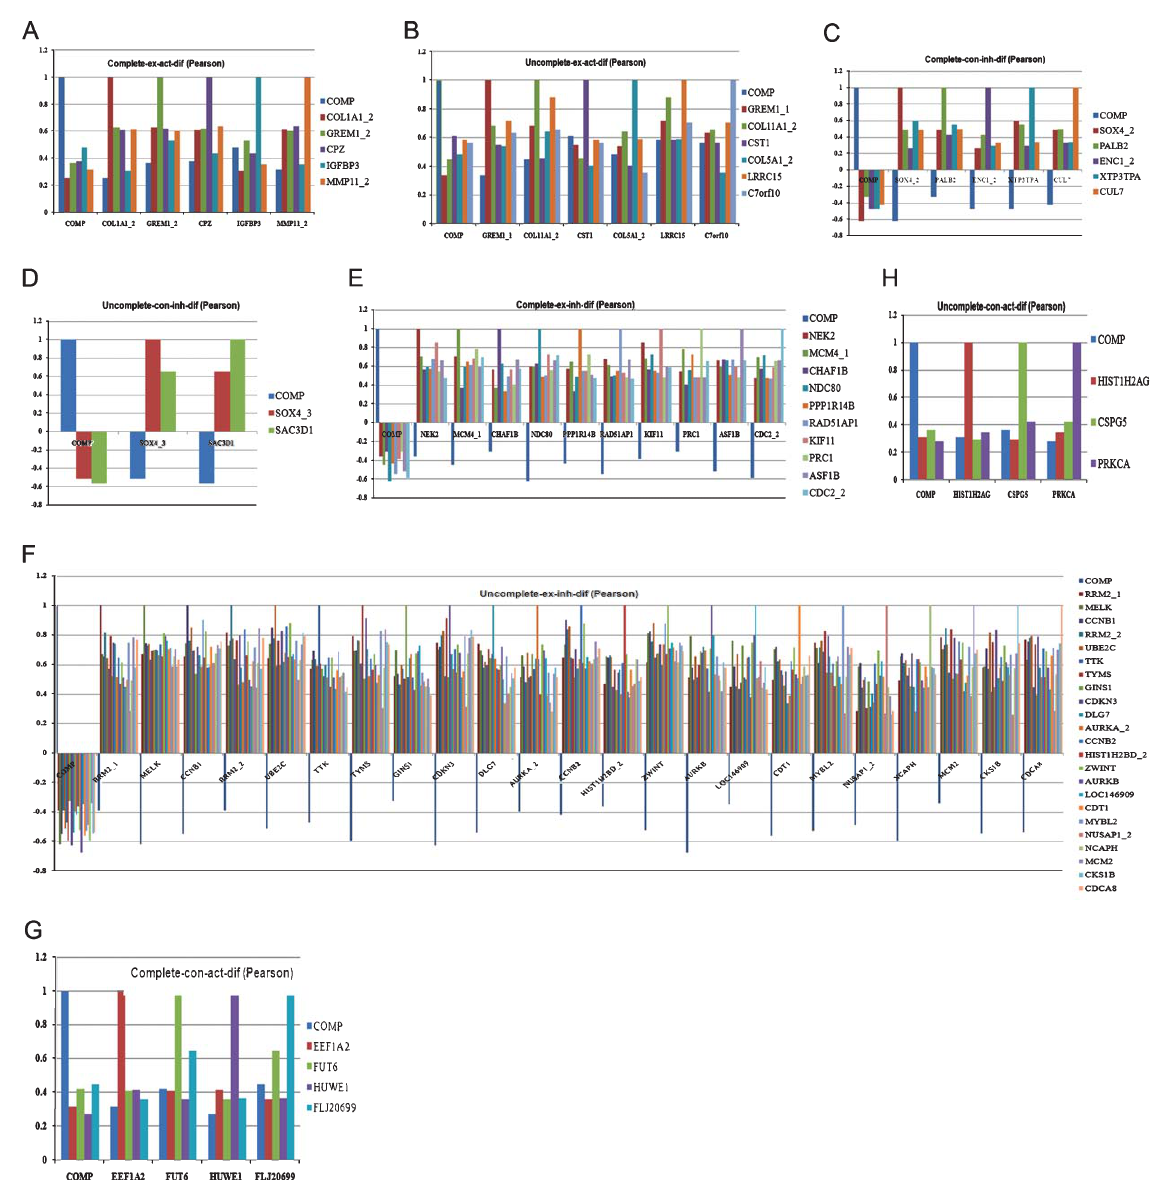
Fig. 1. Novel different COMP -activated and -inhibited networks by correlation coefficient (CC) and our programming. (A) Complete (all no positive correlation, Pearson CC<0.25) and (B) uncomplete (partly no positive correlation except COMP , Pearson CC<0.25) different COMP - activatednetworksgroupedverticalbarsquantificationchartinhigherlungadenocarcinomacomparedwithlowerhumannormaladjacenttissues by Pearson correlation coefficient (CC) and our programming, respectively. Vertical scale bars indicate CC value, n =25. (C) Complete and (D) uncomplete different COMP -inhibited network grouped vertical bars quantification chart in lower human normal adjacent tissues compared with higher lung adenocarcinoma by Pearson CC and our programming, respectively. Vertical scale bars indicate CC value, n =25. (E) Complete and (F) uncomplete different COMP -inhibited network grouped vertical bars quantification chart in higher lung adenocarcinoma compared with lower human normal adjacent tissues by Pearson CC and our programming, respectively. Vertical scale bars indicate CC value, n =25. (G) Complete and (H) uncomplete different COMP -activated network grouped vertical bars quantification chart in lower human normal adjacent tissues compared with higher lung adenocarcinoma by Pearson CC and our programming, respectively. Vertical scale bars indicate CC value, n =25. con, human normal adjacent tissues; ex, lung adenocarcinoma; act, activation; inh, inhibition; dif,